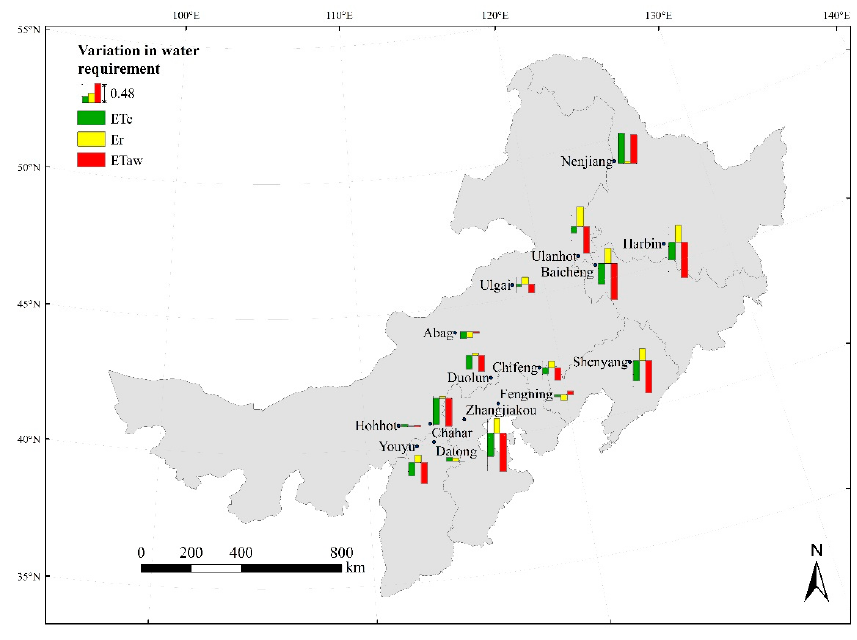
Figure 2. Variation in oat water requirements at 15 stations.